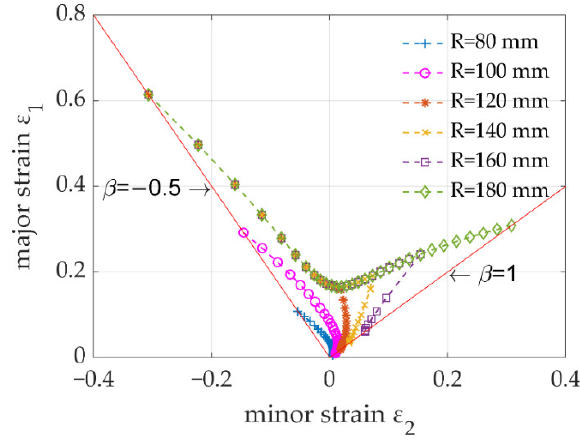
Figure 7. Curvature-radius-dependent FLD for the sandwich panel.